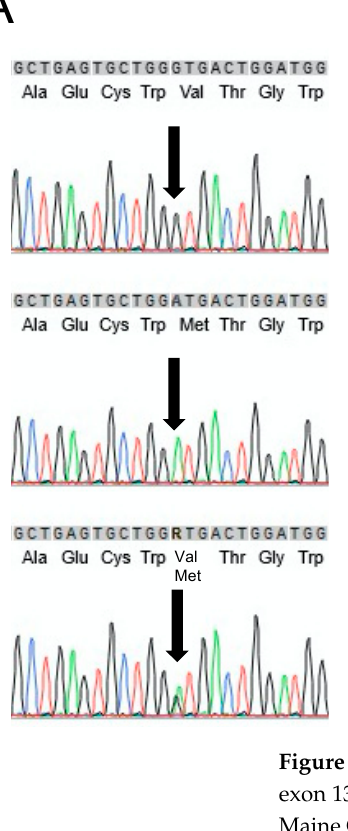
amino acid sequences are based on the initiator methionine in the signal peptide as the first amino acid. Note that the V516M is equivalent to V498M in the human Legacy FXI sequence commonly used for reporting human FXI mutations (EAHAD) in which the first amino acid of the mature plasma protein is designated as residue one